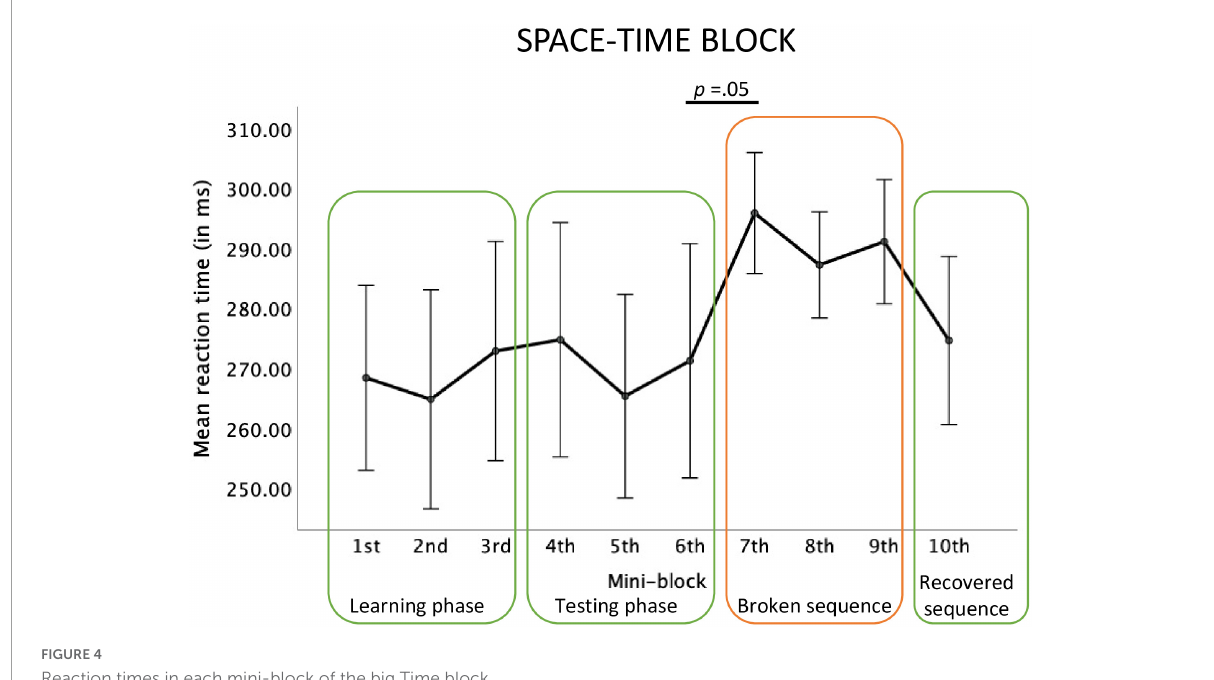
FIGURE4 Reaction times in each mini-block of the big Time block.